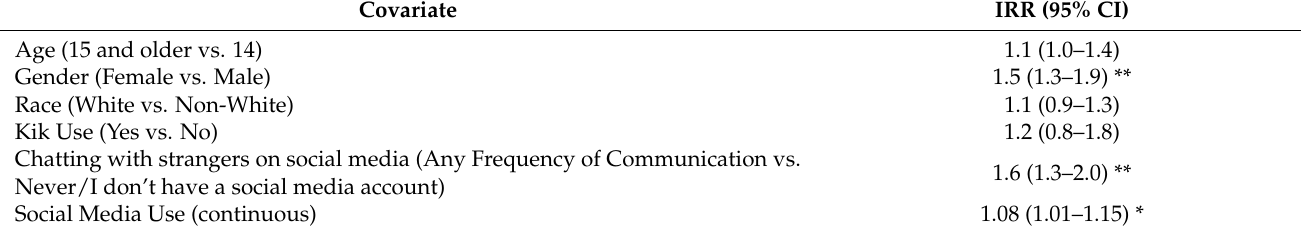
Table 5. Negative Binomial Model for Counts of Types of Risky Online Situations. Covariate IRR (95% CI) Age (15 and older vs.